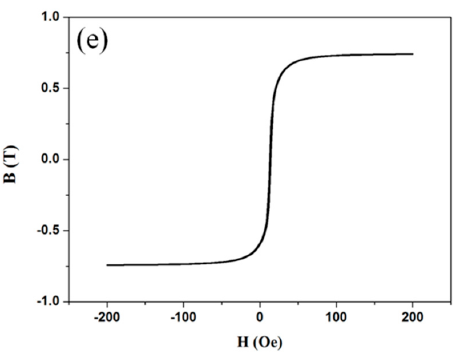
Figure 11. Hysteresis loops of different compositions of Fe 76.5 − x Cu 1 Nb x Si 13.5 B 9 fibers, ( a ) x = 0, d = 25 μ m; ( b ) x = 1, d = 30 μ m; ( c ) x = 2, d = 30 μ m; ( d ) x = 3, d = 20 μ m; ( e ) x = 3.5, d = 15 μ m.